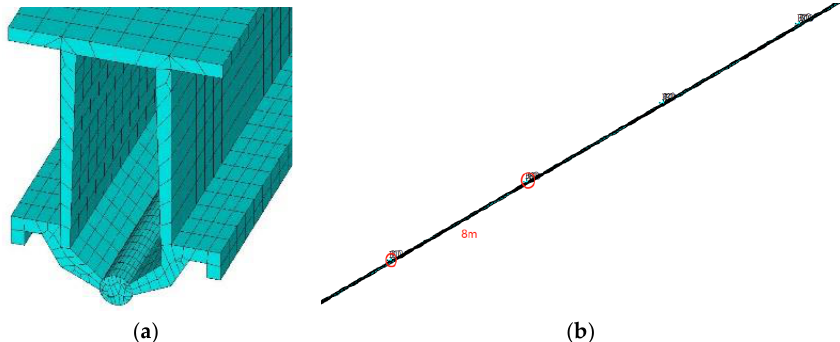
Figure 4. Finite element model of rigid catenary. ( a ) Presents a local view of the mesh on the cross-